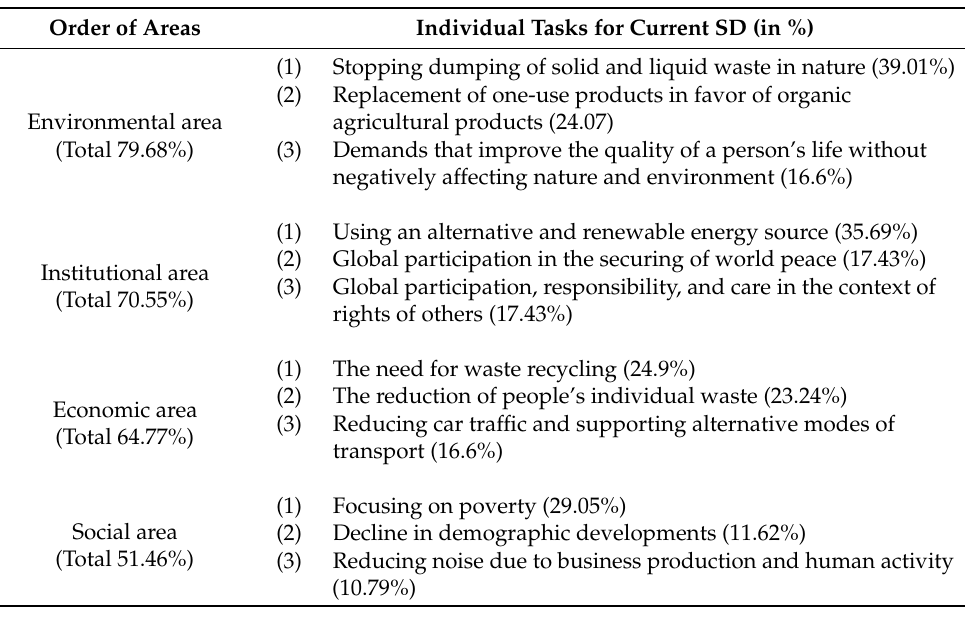
Table 1. Findings of the research—order of areas and individual tasks for current SD according to young